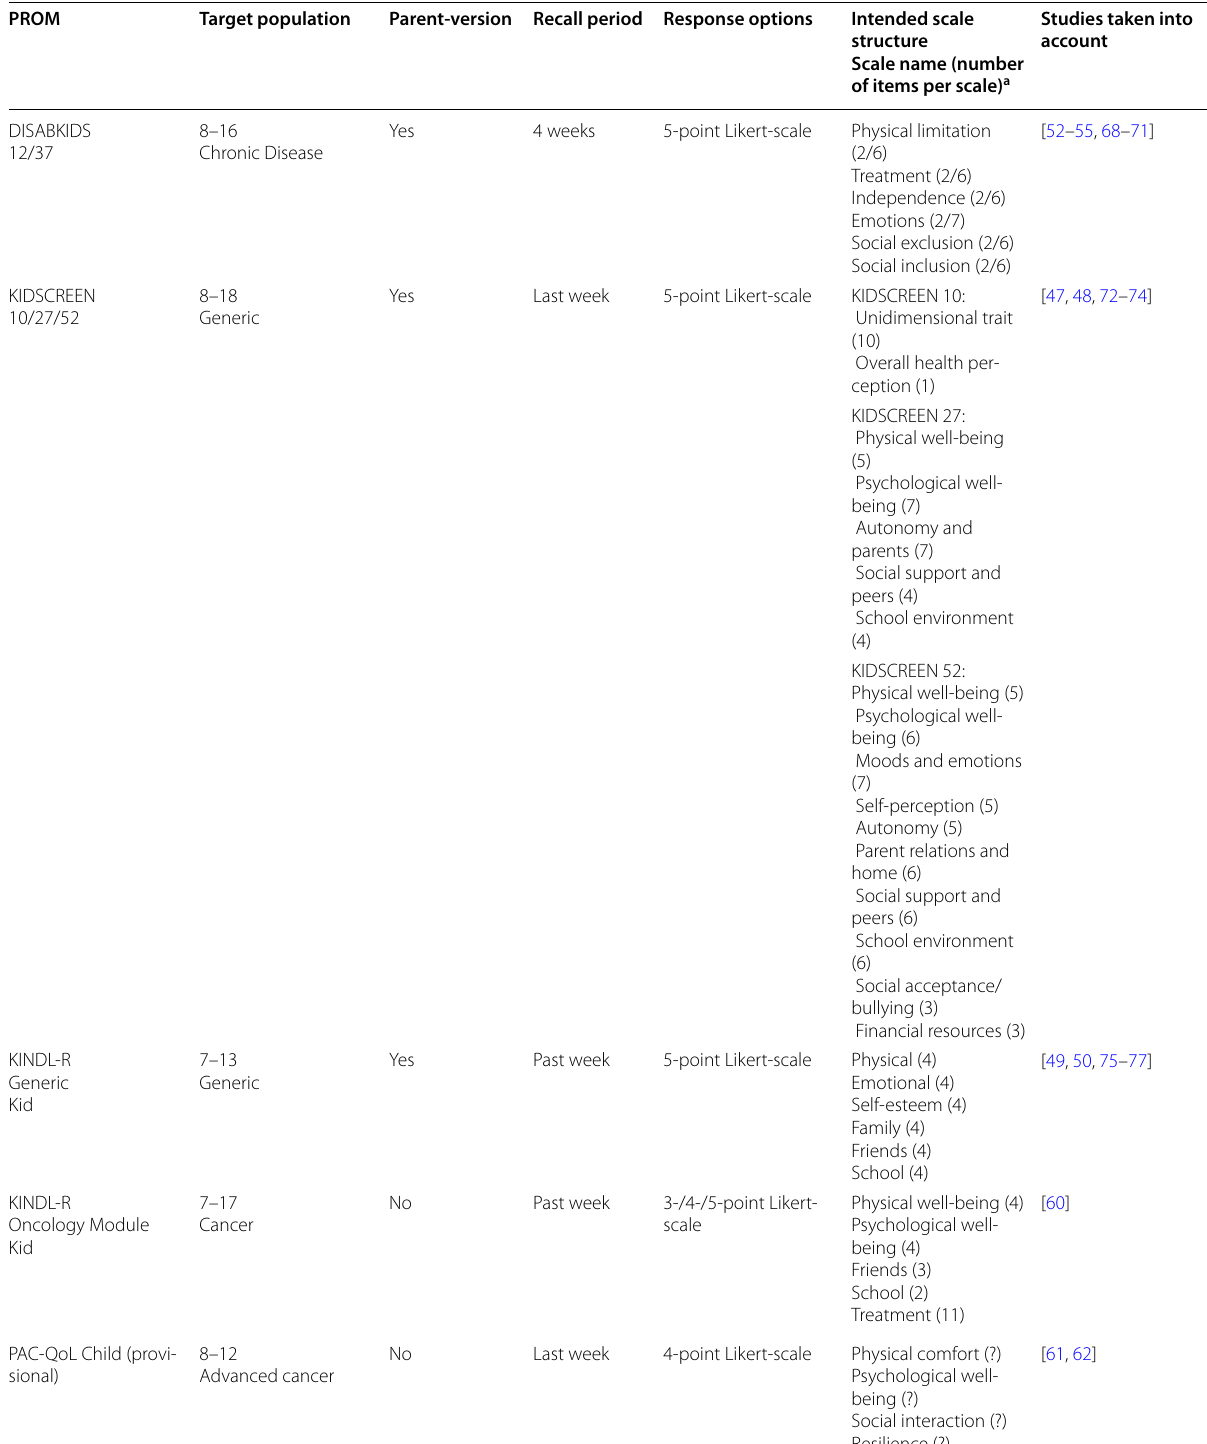
Table 1 Main characteristics of the included Patient‑Reported Outcome Measures